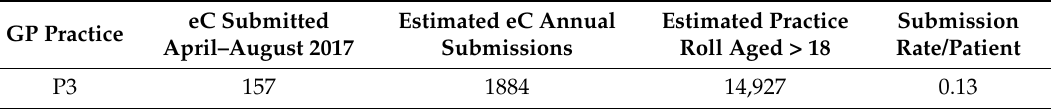
Table A5. Peak eConsult submission